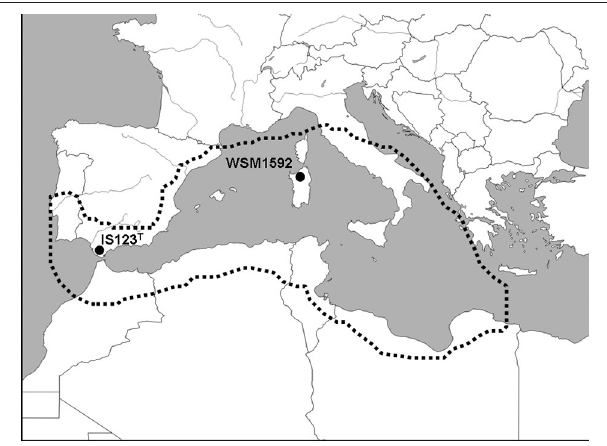
FIGURE 4 | Map of the Western Mediterranean region showing the isolation sites of Rhizobium sullae IS123 T and WSM1592. The dotted line encompasses sites where the host plant Hedysarum coronarium L. ( Sulla coronaria Medik) is currently distributed, and includes areas where the plant has been attributed the status “native” (Algeria, Morocco, Tunisia, Spain), or “uncertain origin,” i.e., possibly introduced (Corsica, Sardinia, Continental Italy, Sicily, Lybia, Egypt). The plant is also naturalized or cropped in other areas, where it has been intentionally introduced, including the Balearic Islands, Portugal, former Yugoslavia, Malta, Lebanon, and Syria. Source of the distribution data: International Legume Database and Information Service